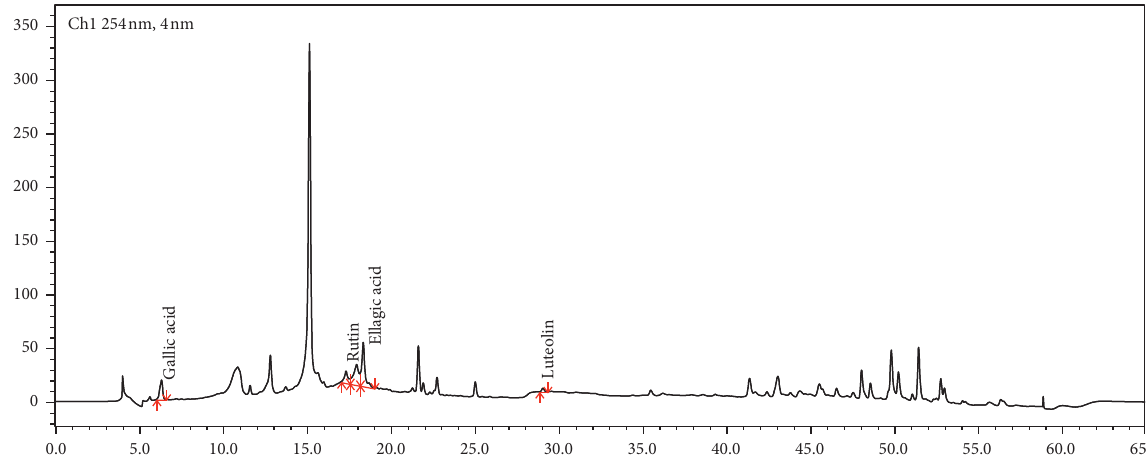
Figure 1: HPLC chromatogram of TOF extract of Punica granatum leaves. Table 3: Antibacterial activity of P. granatum leaf extracts by microdilution method: Minimal Inhibitory Concentration was expressed in mg/mL (diameters of inhibition zones were measured in millimeter